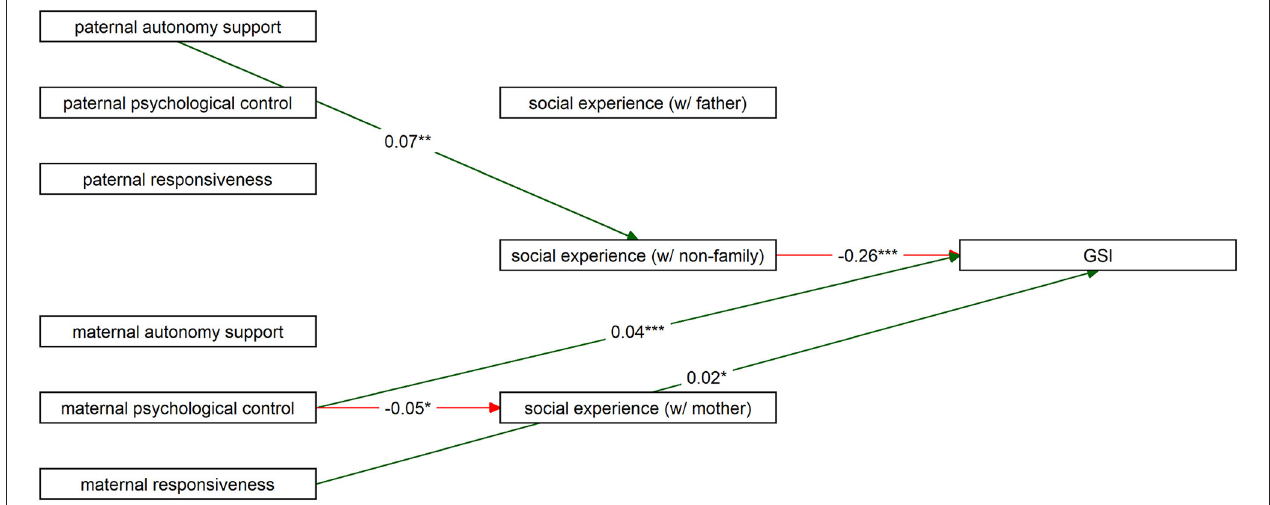
FIGURE 4 | Visualization of comprehensive path model, with only the significant direct associations between variables displayed. Figure was constructed using the ‘tidySEM’ -package (48). GSI, General Severity Index, or mean psychopathology. * p < 0.05; ** p < 0.01; *** p <